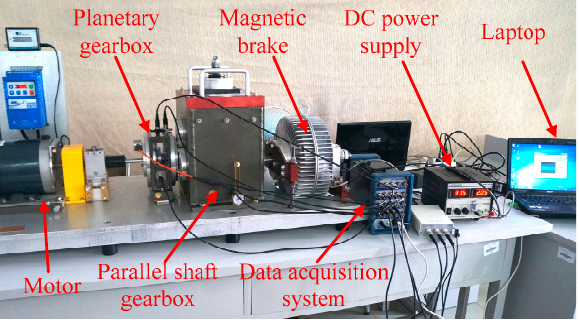
Figure 2. Drivetrain dynamics simulator (DDS) mechanical fault comprehensive simulation bench.